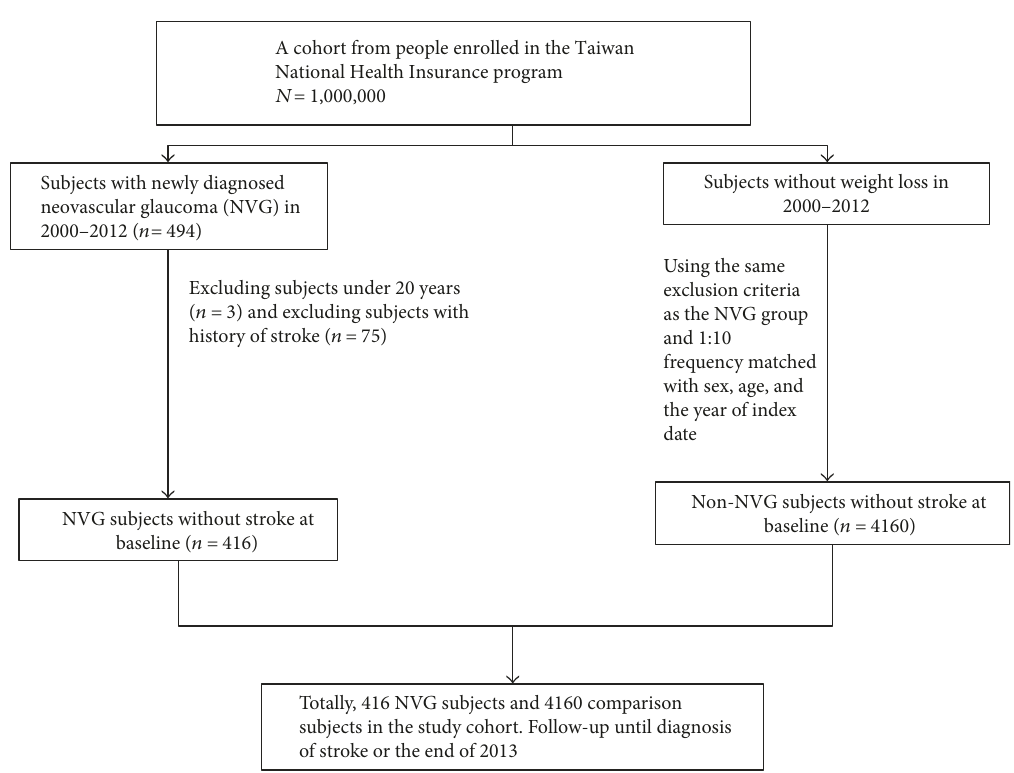
Figure 1: Schematic of selection process of participants in the NGV and control